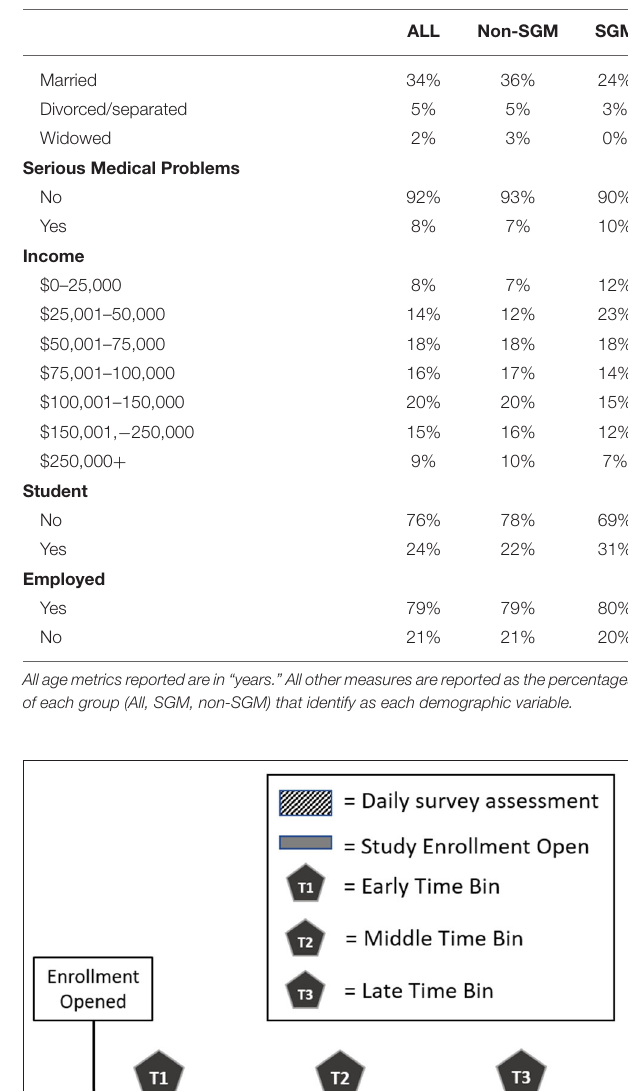
TABLE 1 | Demographics of SGM and non-SGM samples.